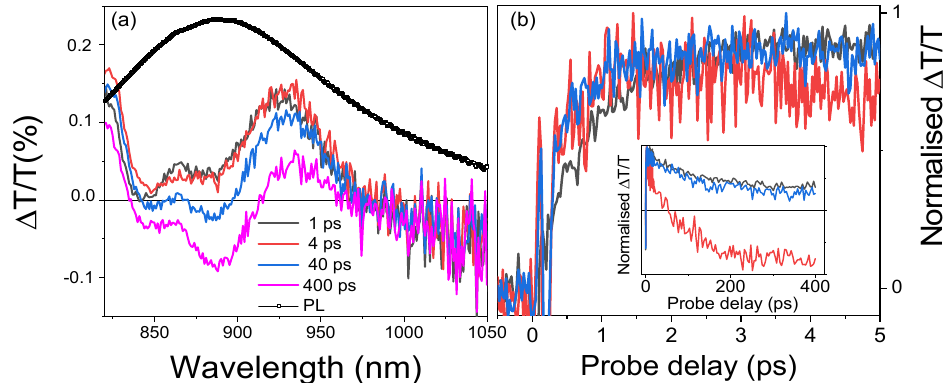
Figure 5. Concentrated solution. ( a ) Transient transmission spectra at different probe delays in the NIR spectral region. The weak PL band is also shown for clarity (grey line with open circles). ( b ) Dynamics at different probe wavelengths: 825 nm (black line), 900 nm (red line), and 930 nm (blue line). In the inset, the same dynamics over a 400 ps temporal window are shown.